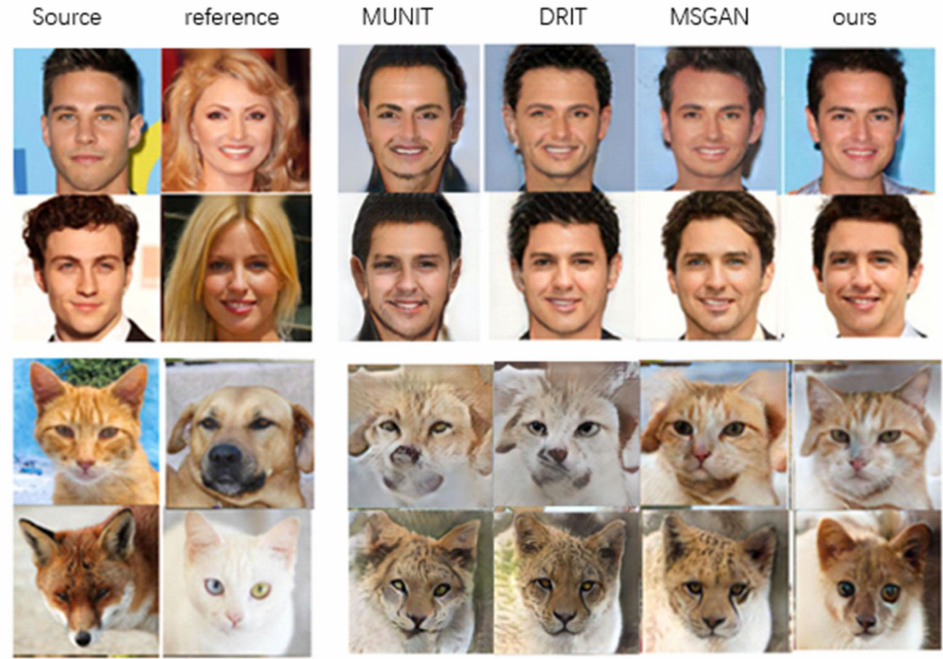
Figure 11. Comparison of reference guided syntheses.